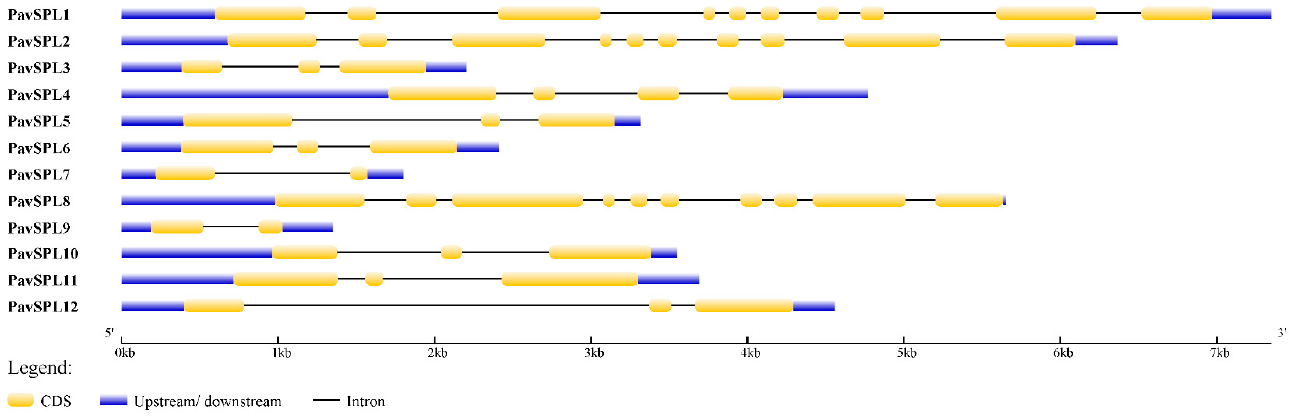
Figure 5. Gene structure of PavSPL genes in the online Gene Structure Display Server (GSDS).